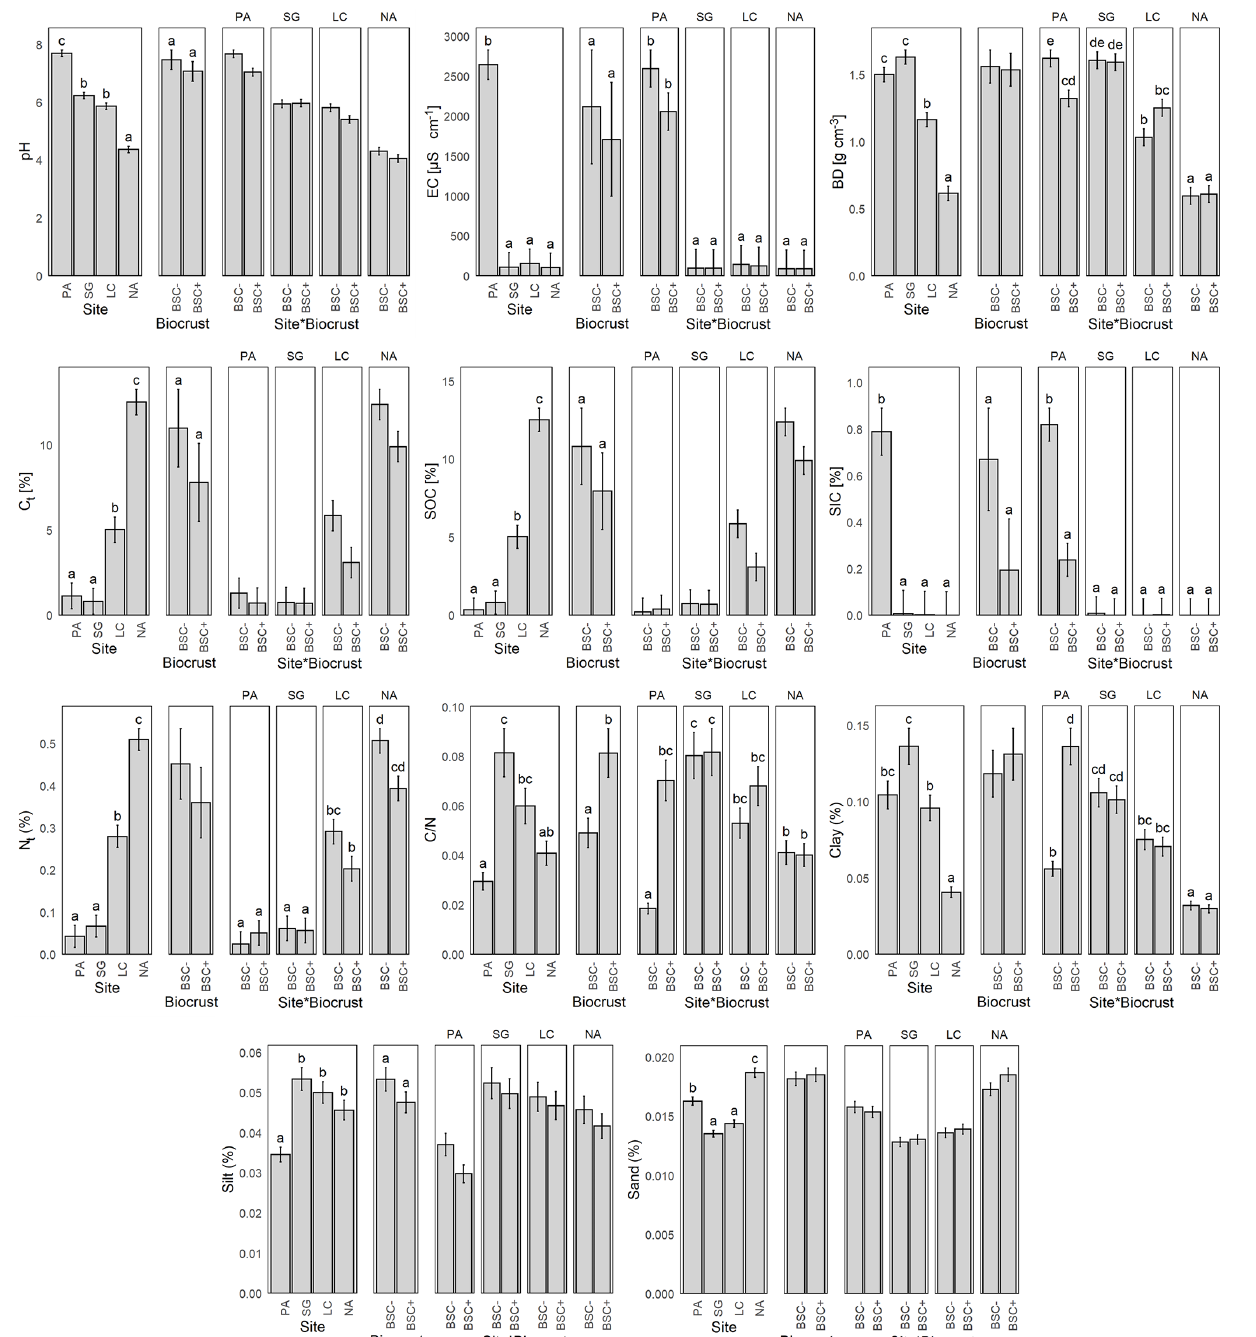
Figure 2. Mean and standard error of soil properties for Pan de Azúcar (PA), Santa Gracia (SG), La Campana (LC), and Nahuelbuta (NA), without (BSC − ) and with biocrust cover (BSC + ), and the interaction of both factors. EC = electrical conductivity, BD = bulk density, C t = total carbon, SOC = soil organic carbon, SIC = soil inorganic carbon, N t = total nitrogen, CN = carbon to nitrogen ratio. Significant factors include Tukey’s post-hoc test indicated by letters on the top of the bars. Different letters represent significant differences at p < 0.05.